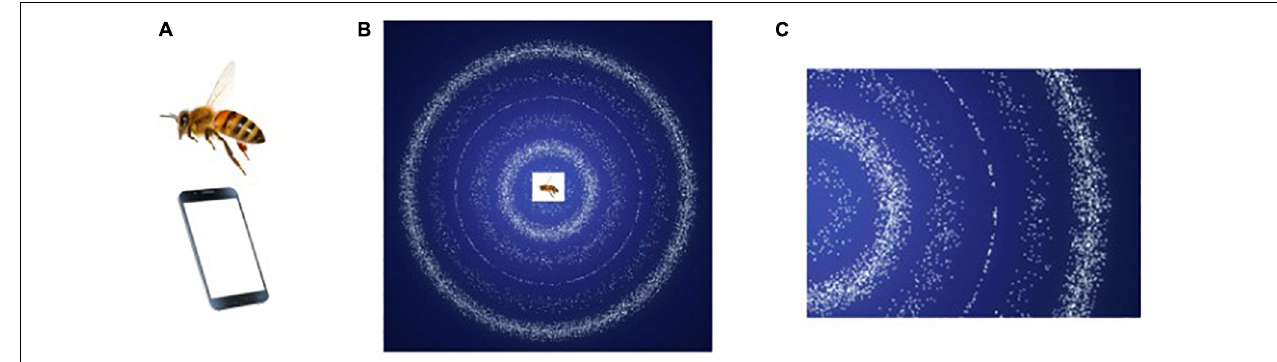
FIGURE 8 | (A–C) Regions with high, medium, and low molecular